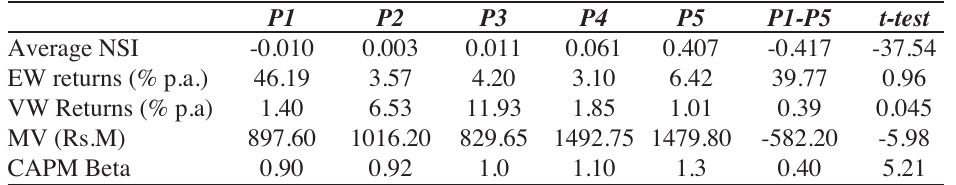
Performance and Statistics of pentile portfolios constructed on the basis of